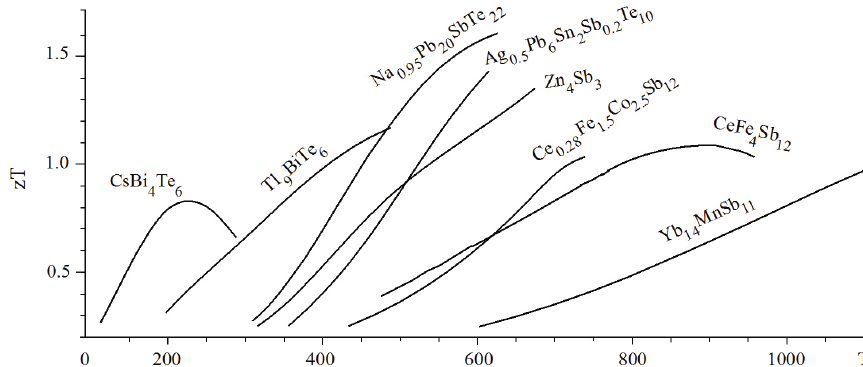
Figure 2. The p-type TMs of academic importance 10-15